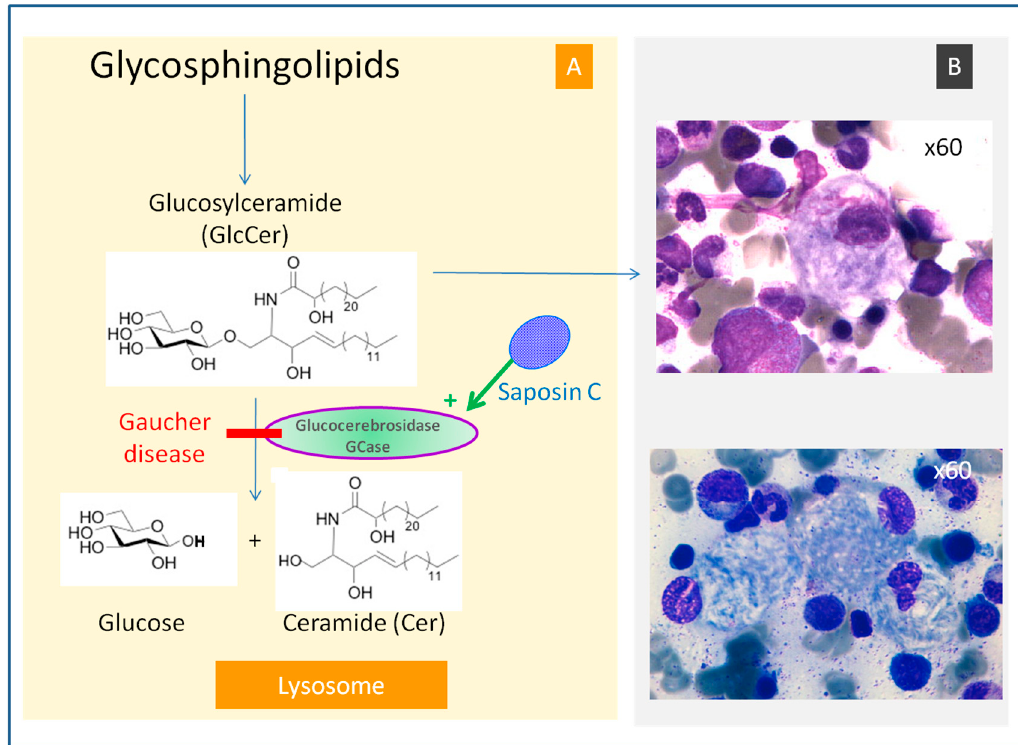
Figure 1. Hydrolysis of glucosylceramide (GlcCer) by glucocerebrosidase (GCase) in the lysosome ( A ). GCase is activated by saposin C. In lysosomal storage diseases, an enzyme deficiency is responsible for the accumulation of its substrate in the cell lysosome (overload disease). Gaucher disease is caused by a deficiency in glucocerebrosidase (GCase) (or β -glucosidase), which leads to an accumulation of GlcCer. GlcCer forms fibrillar aggregates that accumulate in macrophages and result in the cell cytoplasm presenting a characteristic “crumpled tissue paper” appearance ( B ), personal pictures, with the courtesy of Fabrice Camou and Rachid Seddik). These cells, known as Gaucher cells, infiltrate various organs (e.g., bone marrow, spleen, and liver) and are responsible for the major signs of the disease.